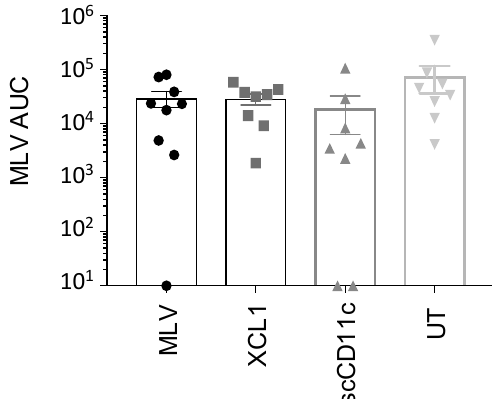
Figure 7. Detection of MLV-FL13b RNA in the sera of immunized pigs. MLV-FL13b was detected in sera with specific qRT-PCR on D29, D36, D42, and D50. TCID 50 / mL equivalence was calculated with a viral standard curve at each time point (see Material and Methods) and the area under the curve (AUC) was extrapolated for each pig. The mean (box) ± sem is shown per group. The symbols are the same as in Figure 6.